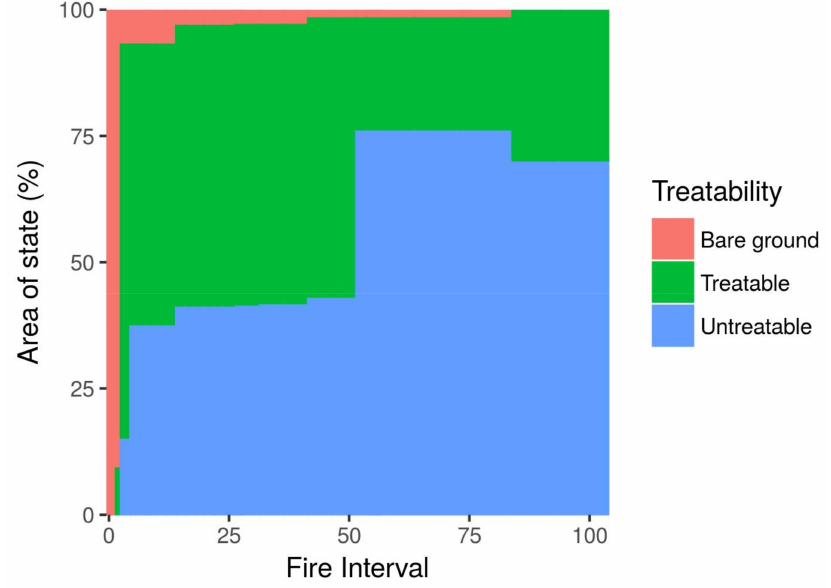
Figure 8. The impact of fire interval on the area of the state requiring fuel